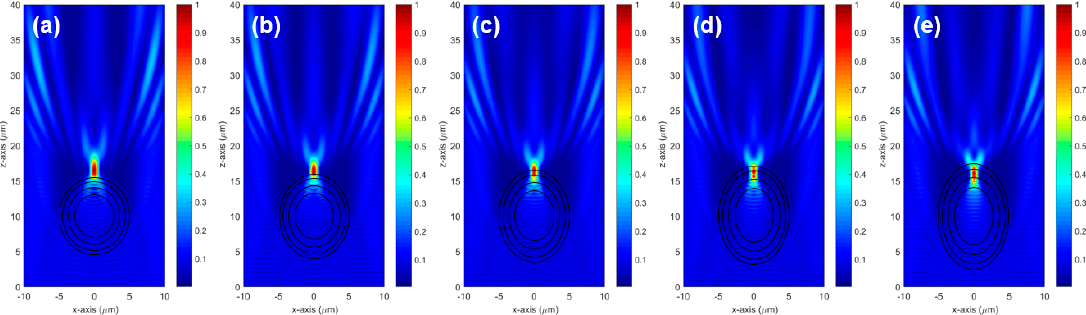
Figure 9. Intensity distributions of the elliptical shape Luneburg lens of the EIS profile with N = 4: ( a ) the aspect ratio A = 1.1, ( b ) 1.2, ( c ) 1.3, ( d ) 1.4 and ( e ) 1.5, respectively. The intensities are normalized. Concentric ellipses depict the step boundary of the index profile.